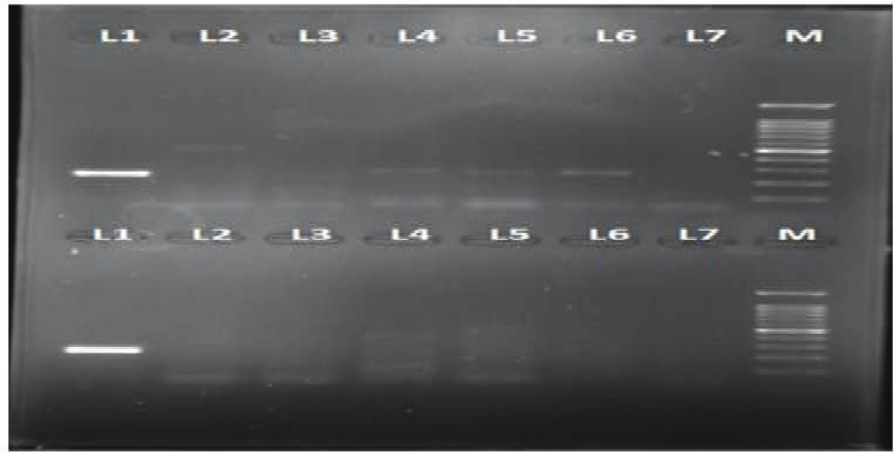
Figure 4 : PCR products on gel electrophoresis under UV light. Upper row right of gel (M): DNA marker; L1: positive control; L7: negative control; L4–L6: positive samples for MTB complex; L2 and L3: negative for MTB